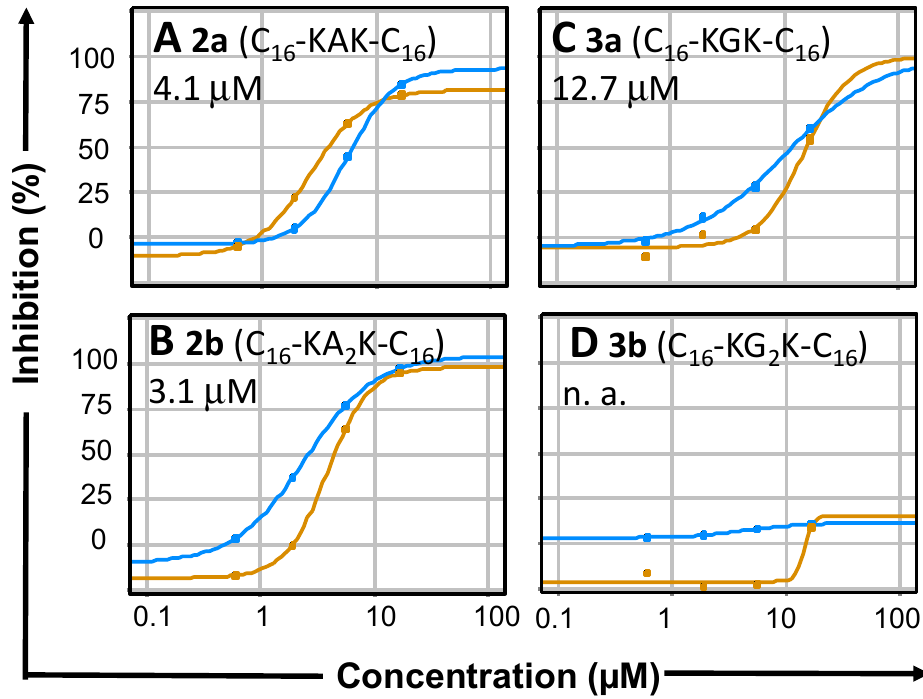
Figure 4. Dose-response curves for the virus infection assay with LLC-MK2 cells for geminoids 2 (left: Panel ( A ), compound 2a , Panel ( B ), compound 2b ) and 3 (right: Panel ( C ), compound 3a ; Panel ( D ), compound 3b ). The assay, which reports the percentage of infected cells by an immunochemical approach, was performed in duplicate (series-1 and series-2) at 8 concentrations (three-fold dilutions), see Table 1 for averaged EC 50 values with standard deviation from curve fits; n. a., not active.